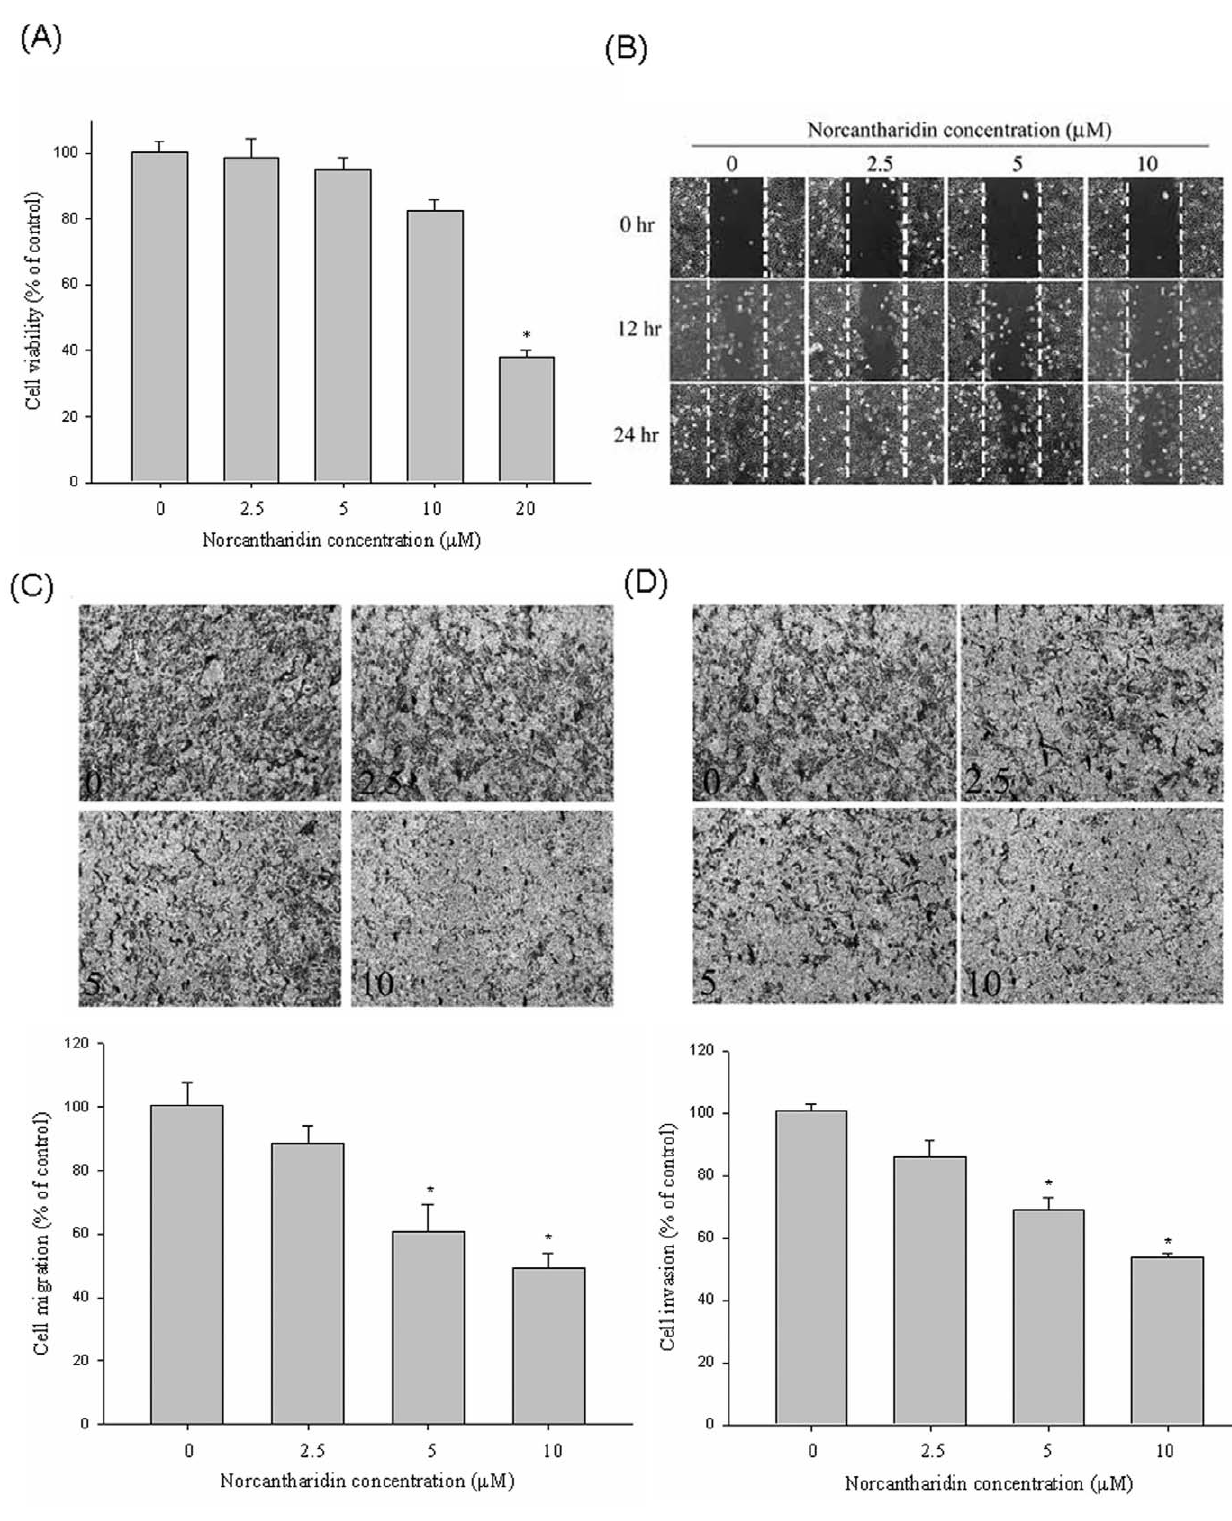
Figure 1. Effect of NCTD on cell viability, invitro wound closure, cell migration and invasion in Huh7 cells. (A) Huh7 cells were treated with NCTD (0, 2.5, 5, 10 and 20 m M) for 24 h before being subjected to a MTT assay for cell viability. The values represented the means 6 SD of at least three independent experiments. (B) Huh7 cells were wounded and then treated with vehicle (DMSO) or NCTD (2.5, 5 and 10 m M) for 0 h, 12 h and 24 h in 0.5% FBS-containing medium. At 0, 12 and 24 h, phase-contrast pictures of the wounds at three different locations were taken. (C & D) Figure C&D showing the cell migration and invasion were measured using a Boyden chamber for 16 h and 24 h with polycarbonate filters respectively. The migration and invasion abilities of Huh7 cells were quantified by counting the number of cells that invaded to the underside of the porous polycarbonate as described in the Materials and Methods section. The values represented the means 6 SD of at least three independent experiments. *P , 0.05 as compared with the vehicle group. doi:10.1371/journal.pone.0031055.g001 PLoS ONE |